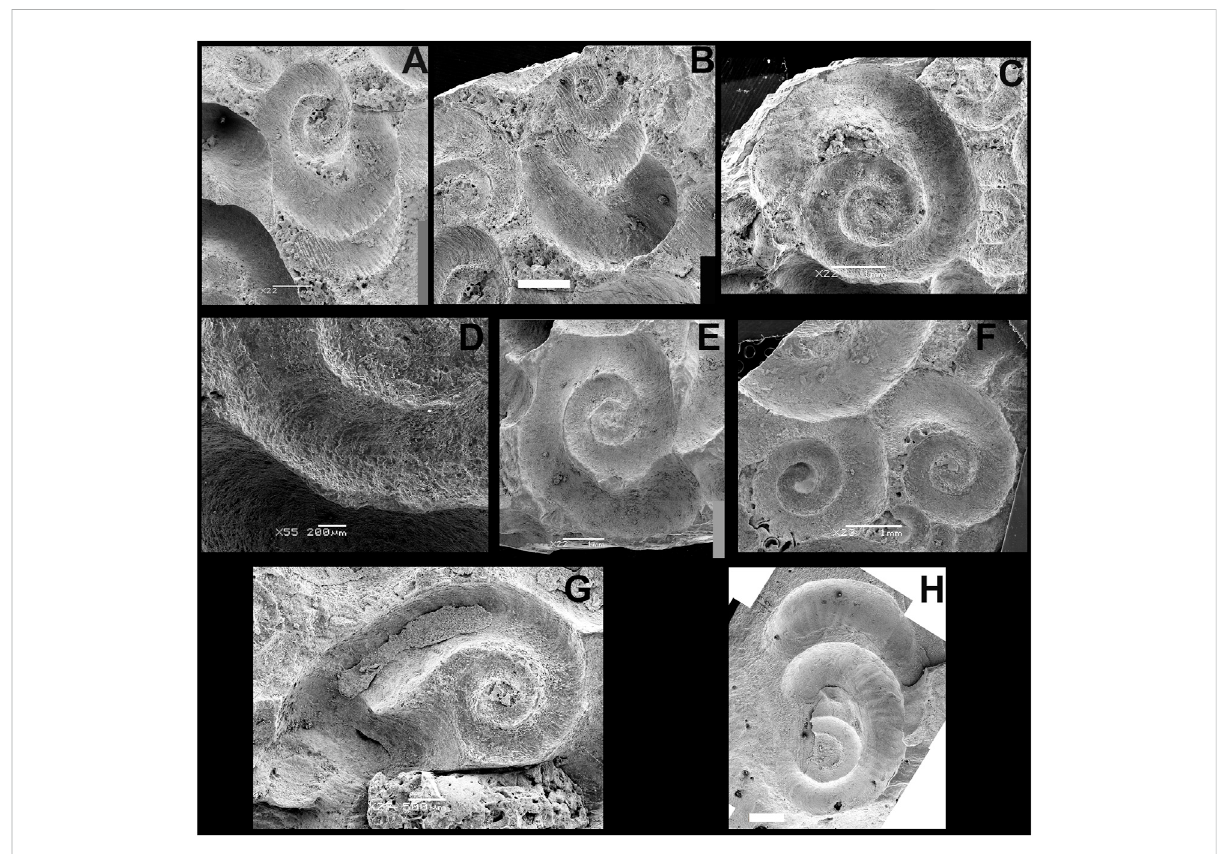
FIGURE 6 SEM images of Santichnus mayorali ichnogen. nov., ichnosp. nov. showing different morphological variants. (A) FPA 7 J and (B) FPA 7 C with xenoglyph of the substratum mollusk shell. (C) FPA 7 E. (D) Detail of FPA 7 E showing fi ne grooves and ridges. (E) FPA 7 A. (F) FPA 7 H on the right. (G) FPA 7 G with fi ne grooves and ridges. (H) FPA 1 showing fi ne grooves and ridges, associated with a reniform scar in its last whorl (upper part of the specimen). Scale bars: (A – C, E – F,H) , 1 mm; (D) 200 microns, (G) 500 microns.